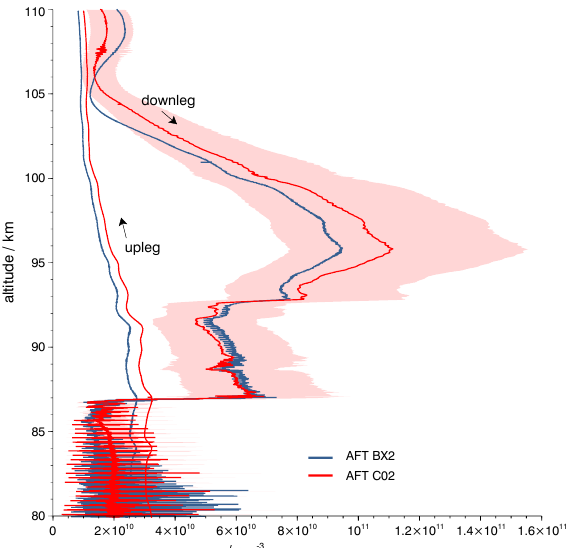
Figure 12. Measurement results for atomic oxygen number density vs. altitude for sensors on the aft deck during the up- and downleg without aerodynamic correction. The shading shows the uncertainty from the calibration for the aft sensor CO2.